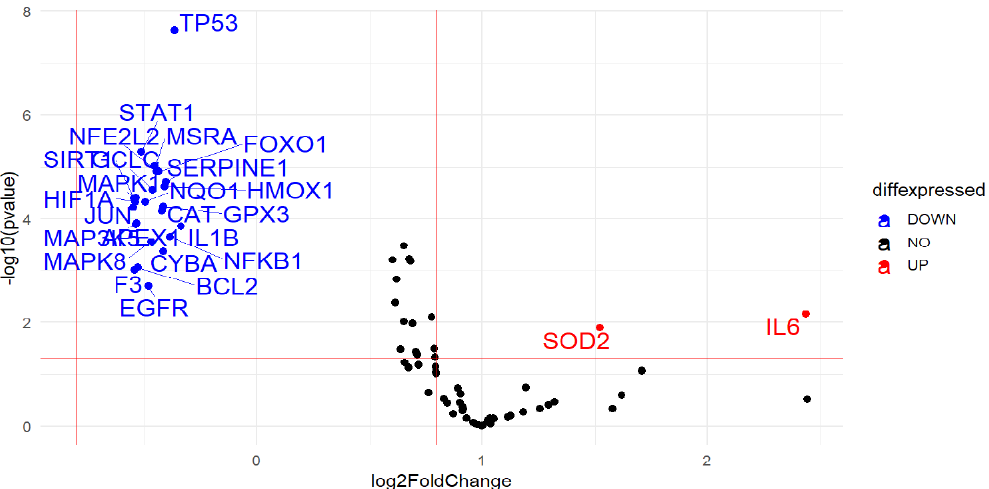
Figure 2. Volcano plot of statistical significance against fold- change of differentially expressed genes between female smokers and non-smokers indicating the most upregulated genes towards the right, the most downregulated genes towards the left and the most statistically significant genes towards the top.